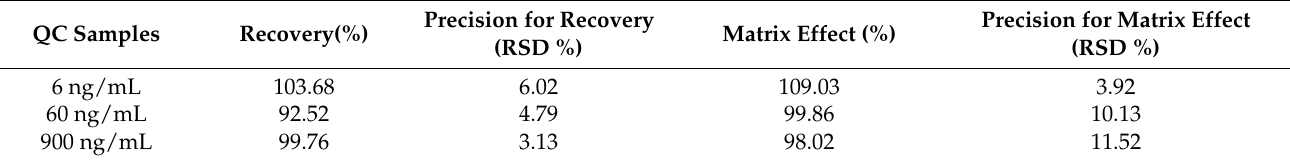
Table 4. Recovery and matrix effect for oxypeucedanin in rat plasma ( n =